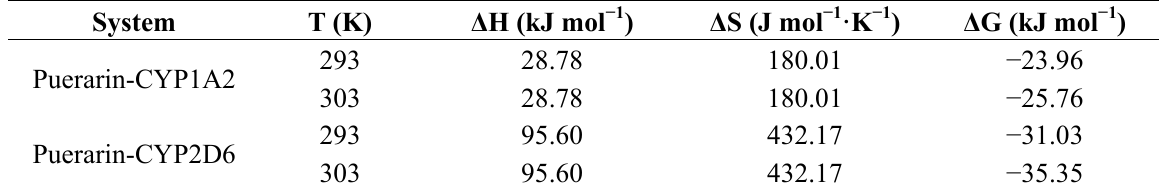
Table 3. Thermodynamic parameters for the associations of puerarin with